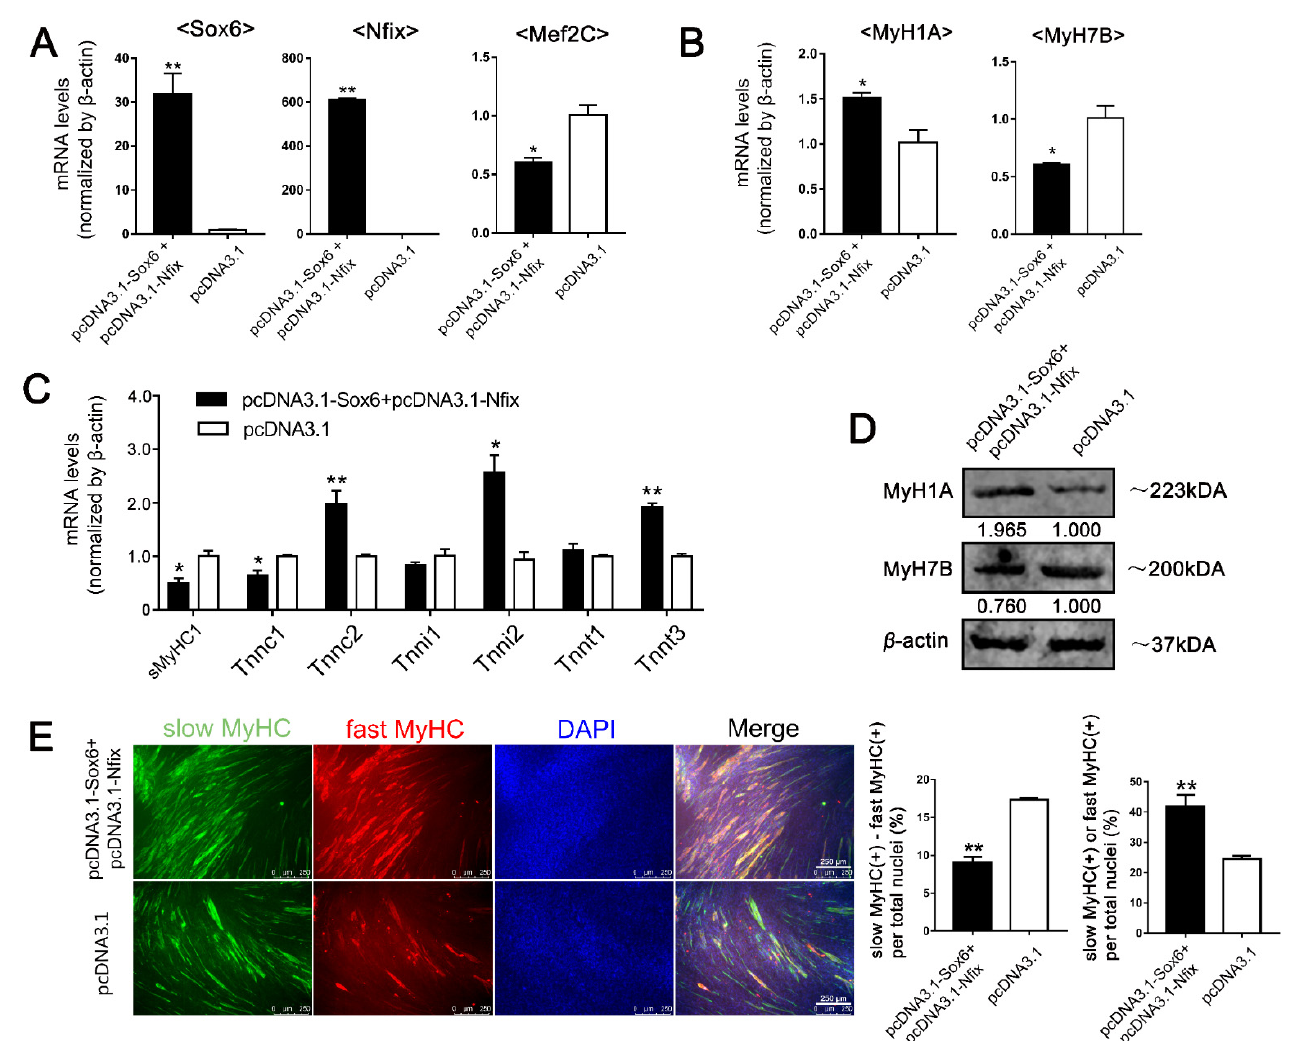
Figure 7. Overexpression of Sox6 in Nfix -overexpressing LM-MTs inhibits the expression of Mef2C and slow-type fiber isoforms. ( A ) After inducing differentiation for 3 days, the relative expression levels of Sox6 , Nfix and Mef2C in Sox6 -overexpressing LM-MTs with Nfix overexpression were quantified by qPCR (mean ± SEM; * p < 0.05; ** p < 0.01; n = 3; two-tailed Student’s t -test). ( B ) After inducing differentiation for 3 days, the relative expression levels of MyH1A and MyH7B in Sox6 -overexpressing LM-MTs with Nfix overexpression were quantified by qPCR (mean ± SEM; * p < 0.05; n = 3; two-tailed Student’s t -test). ( C ) After inducing differentiation for 3 days, the relative expression levels of fast- and slow-type fiber isoforms in Sox6 -overexpressing LM-MTs with Nfix overexpression were quantified by qPCR (mean ± SEM; * p < 0.05; ** p < 0.01; n = 3; two-tailed Student’s t-test). ( D ) Western blot on lysates from Sox6 -overexpressing LM-MTs with Nfix overexpression and control group myotubes after inducing differentiation for 3 days. β -actin was used to normalize. ( E ) After inducing differentiation for 3 days, myotubes derived from Sox6 -overexpressing LM-MTs with Nfix overexpression were performing immunofluorescence double staining against S58 (slow-type MyHC, green) and F59 (fast-type MyHC, red) and nuclei were counterstained with DAPI. The slow MyHC(+) nuclei or fast MyHC(+) nuclei were counted. The proportion of slow MyHC(+) cells − fast MyHC(+) cells among total nuclei and the proportion of cells in slow MyHC(+) myotubes or fast MyHC(+) myotubes among total nuclei are presented as mean ± SEM (** p < 0.01; n = 3; two-tailed Student’s t -test). In addition, we noticed that Sox6 promoted the expression of fast-type isoforms in PM-MTs and LM-MTs with or without the presence of Nfix . Therefore, we performed